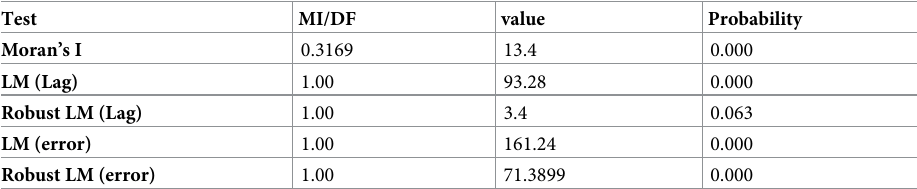
Table 2. Results of diagnostic test of spatial dependence in OLS and other spatial